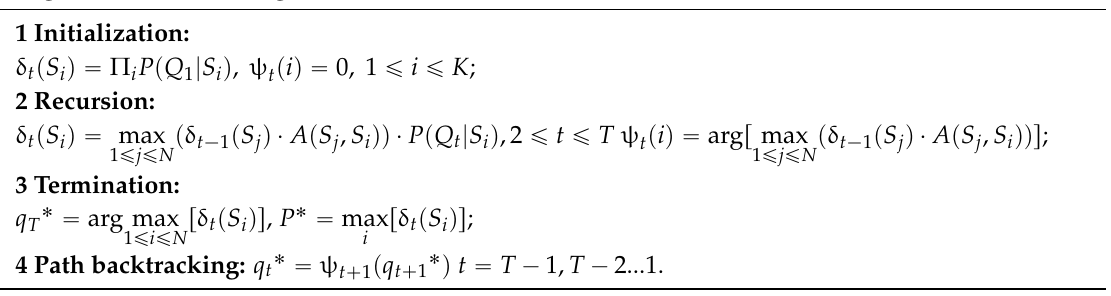
Algorithm 2: Viterbi algorithm